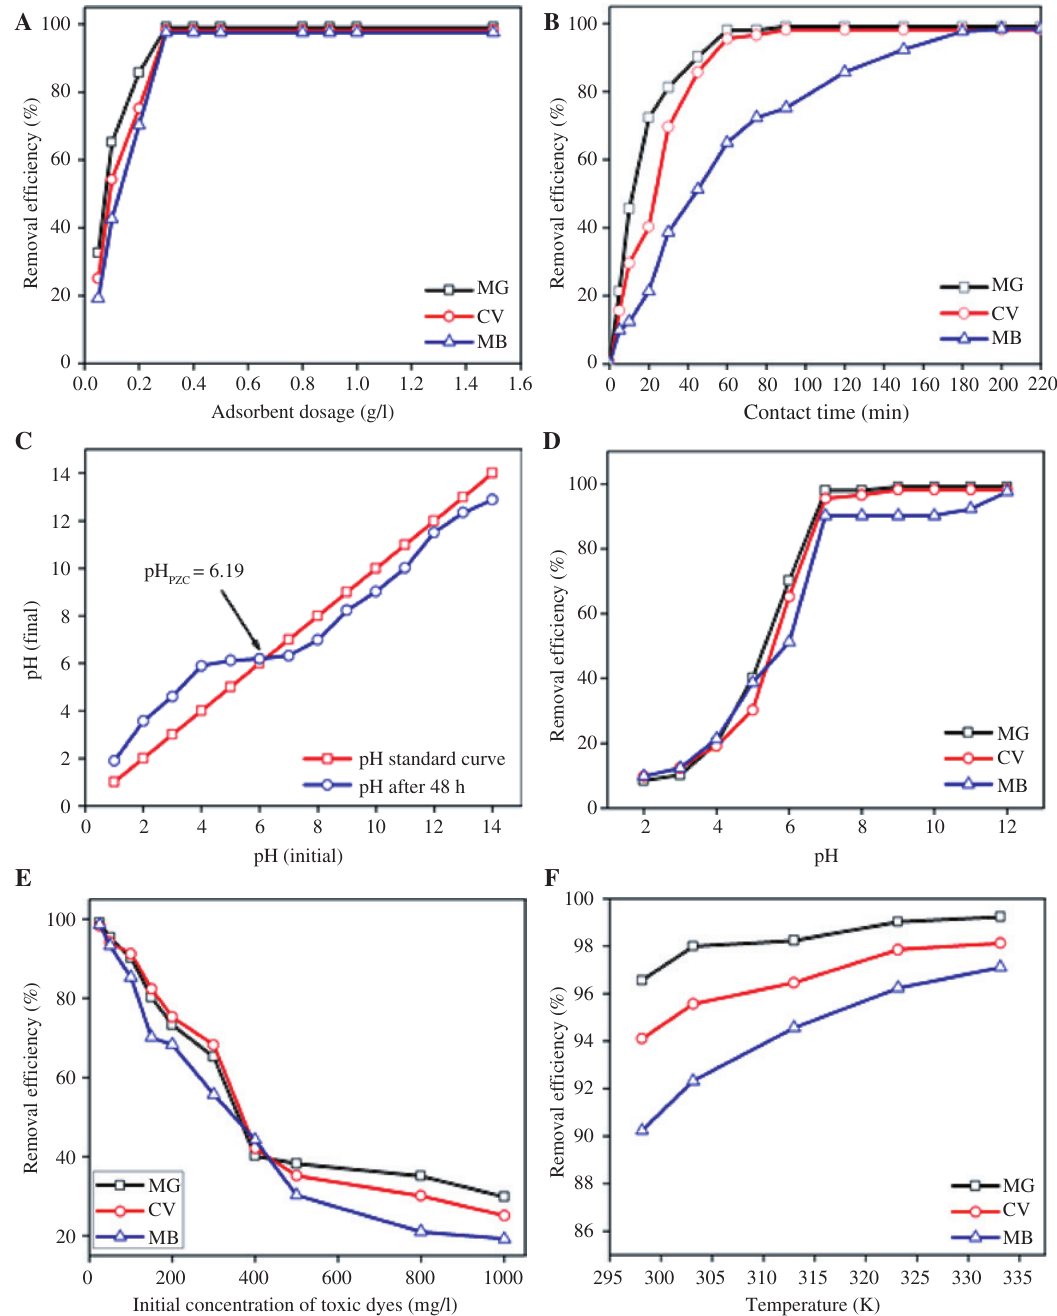
Figure 12: The removal/degradation of malachite green (MG), crystal violet (CV) and methylene blue (MB) at various operating conditions. = 25 mg/l, pH = 6.5, Temp = 298.15 K, dosages = 0.05–1.5 g/l and contact time = 3 h; (B) effects of (A) Effects of the adsorbent dosages: C o = 25 mg/l, pH = 6.5, Temp = 298.15 K and dosages = 0.3 g/l; (C) pH contact time: C o = 25 mg/l, pH = 2–12, Temp = 298.15 K and dosages = 0.3 g/l; (E) effects of the initial concentration of toxic (D) effects of the solution pH: C o = 25–1000 mg/l, pH = 6.5, Temp = 298.15 K and dosages = 0.3 g/l; and (F) effects of the reaction temperatures: C dyes: C o Temp = 298.15–333.15 K and dosages = 0.3